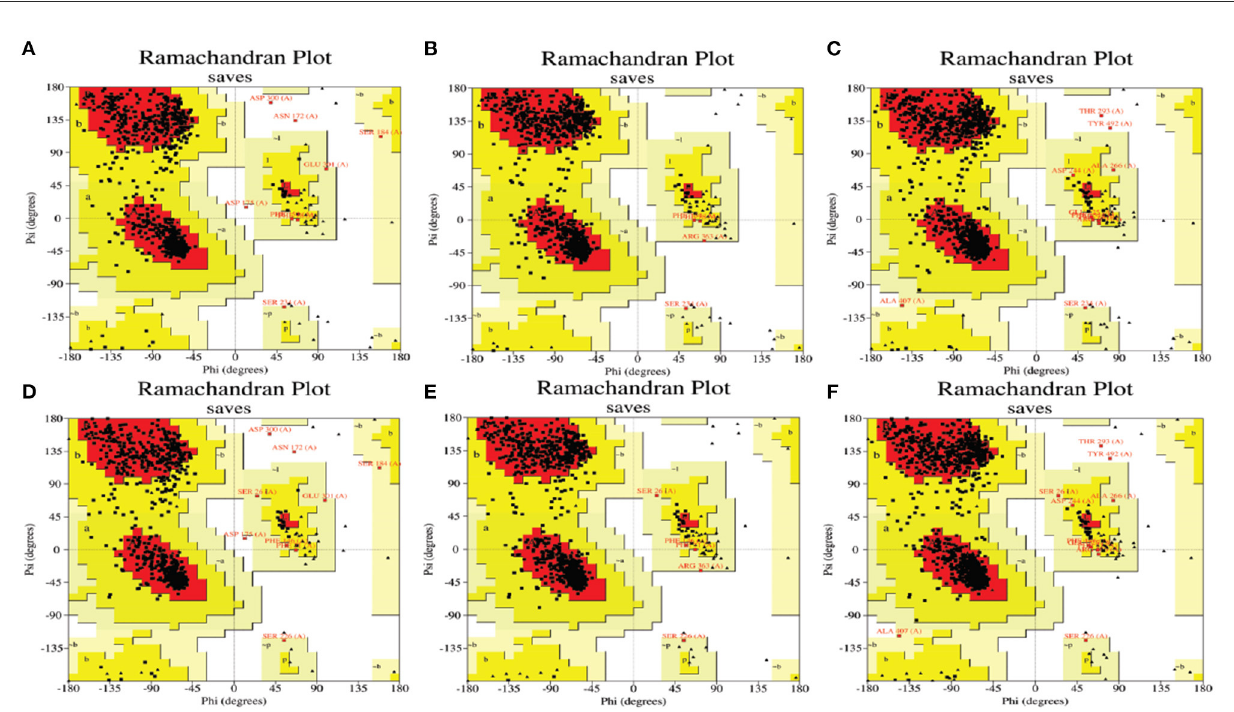
FIGURE7 The Ramachandran plot for docking models. The higher number of dots in the red area represent the increased reliability of the model. The models for CD44 and ACHE (A) , LCK and ACHE (B) , ZAP70 and ACHE (C) , CD44 and BCHE (D) , LCK and BCHE (E) , and ZAP70 and BCHE (F)